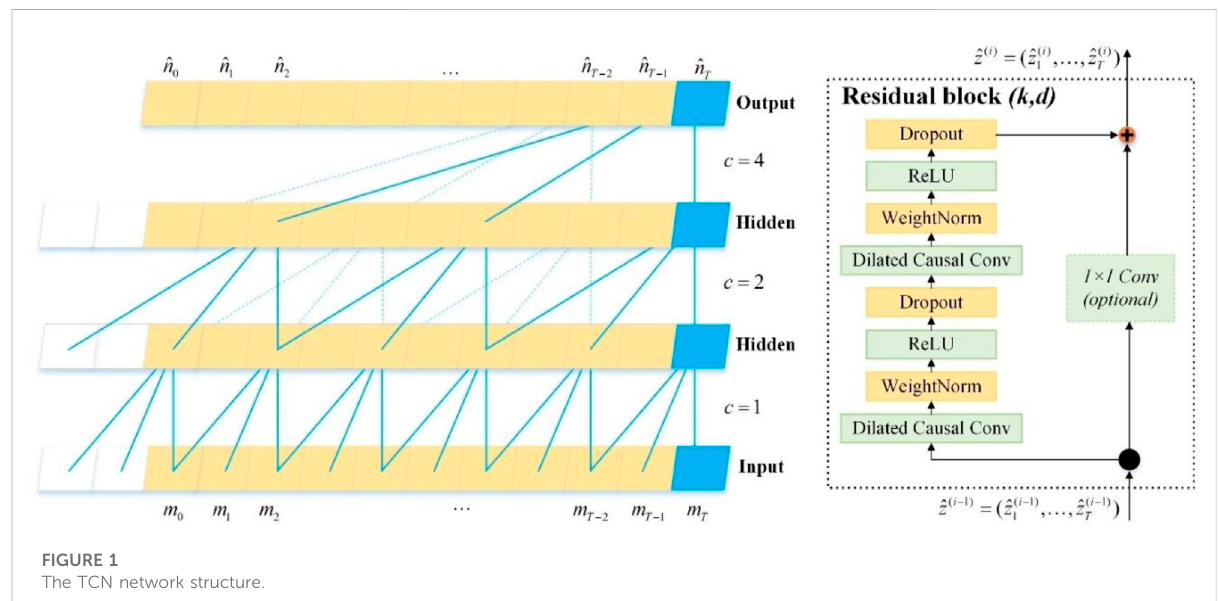
FIGURE 1 The TCN network